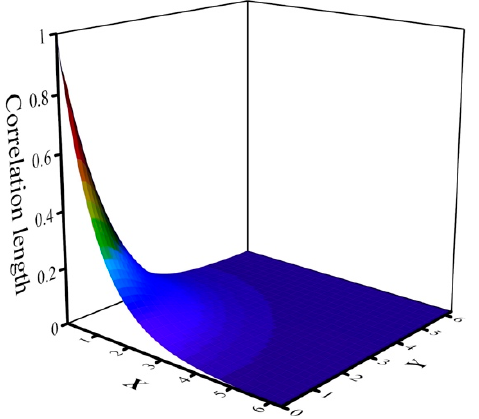
Figure 4. The spatial correlation model in two ‐ dimensional space (X: d x / l x ; Y: d y / l y ).